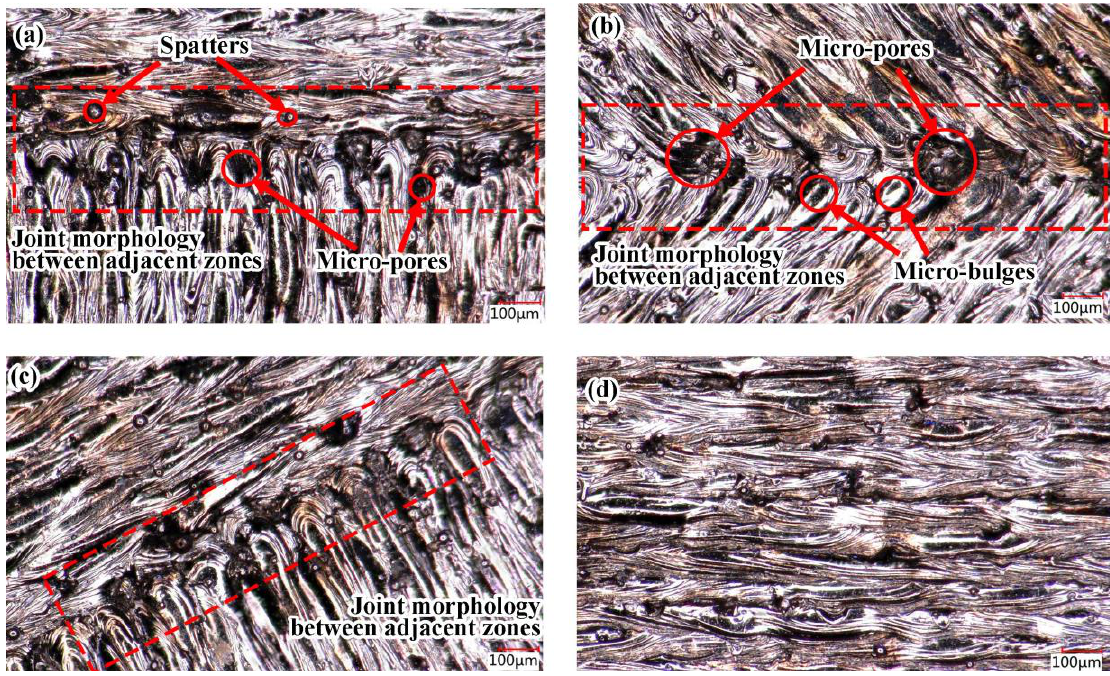
Figure 7. The surface morphology graph of overlap (magnification 200×): ( a ) Normal partition strategy; ( b ) Oblique line and layer-staggered divisional strategy; ( c ) Spiral divisional strategy; ( d ) “s” style orthogonal scanning strategy.